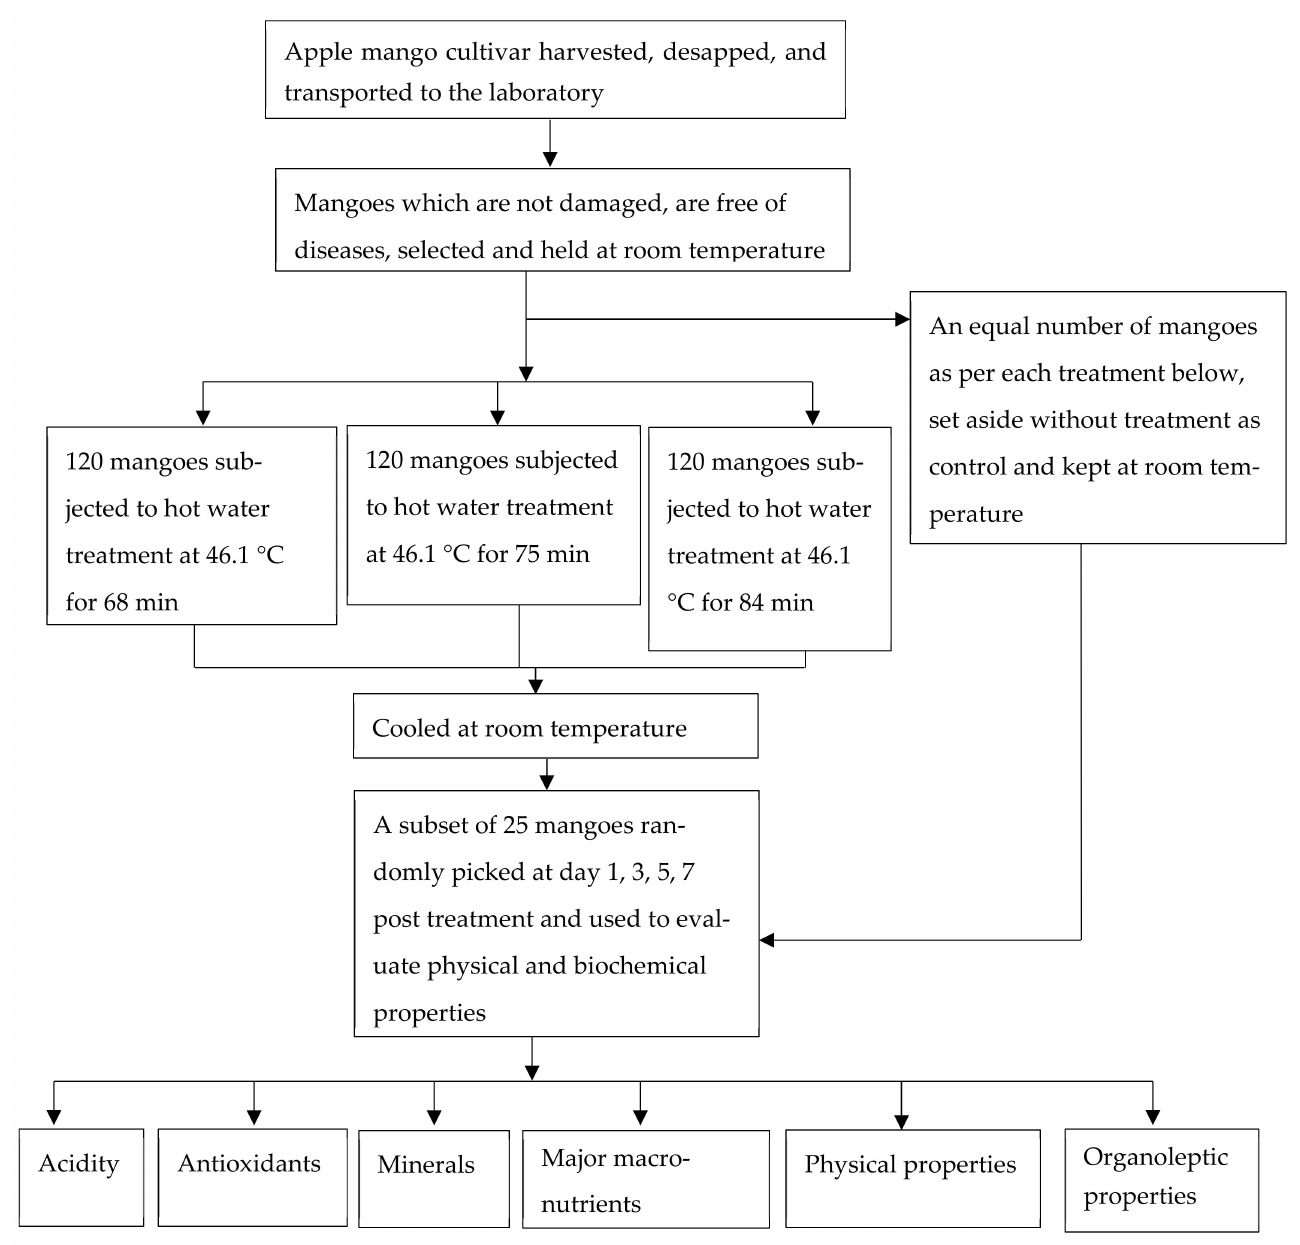
Figure 2. The general workflow of the methodology used to treat Apple mango cultivar using hot water disinfestation treatment and evaluate the treatment effect on physical and biochemical properties of the mango